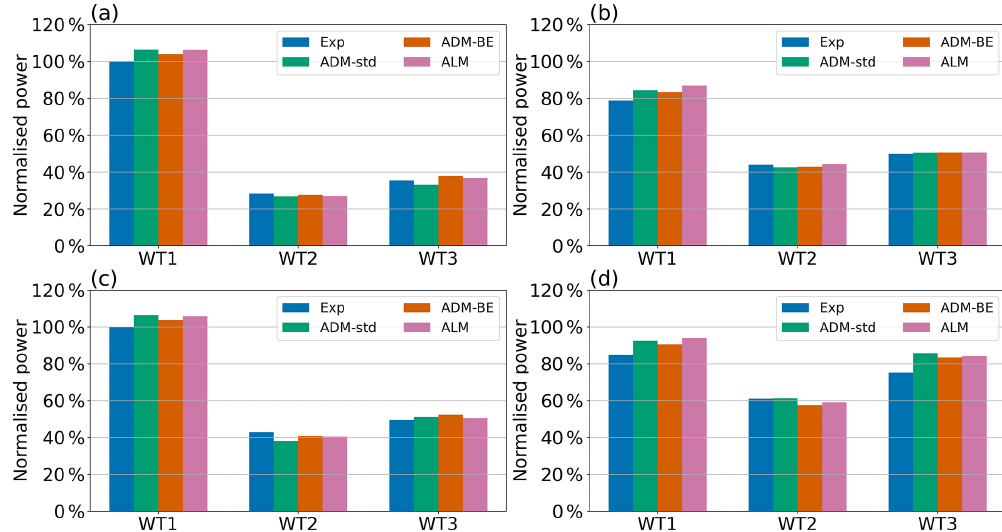
Figure 14. Normalised power outputs in (a) Case 1: γ = (0 , 0 , 0 ◦ ), zero offset; (b) Case 2: γ = (25 , 15 , 0 ◦ ), zero offset; (c) Case 3: γ = (0 , 0 , 0 ◦ ), D/ 3 offset; (d) Case 4: γ = (20 , 20 , 0 ◦ ), D/ 3 offset. The power outputs are normalised by the measured power of the zero-yawed first turbine of the turbine